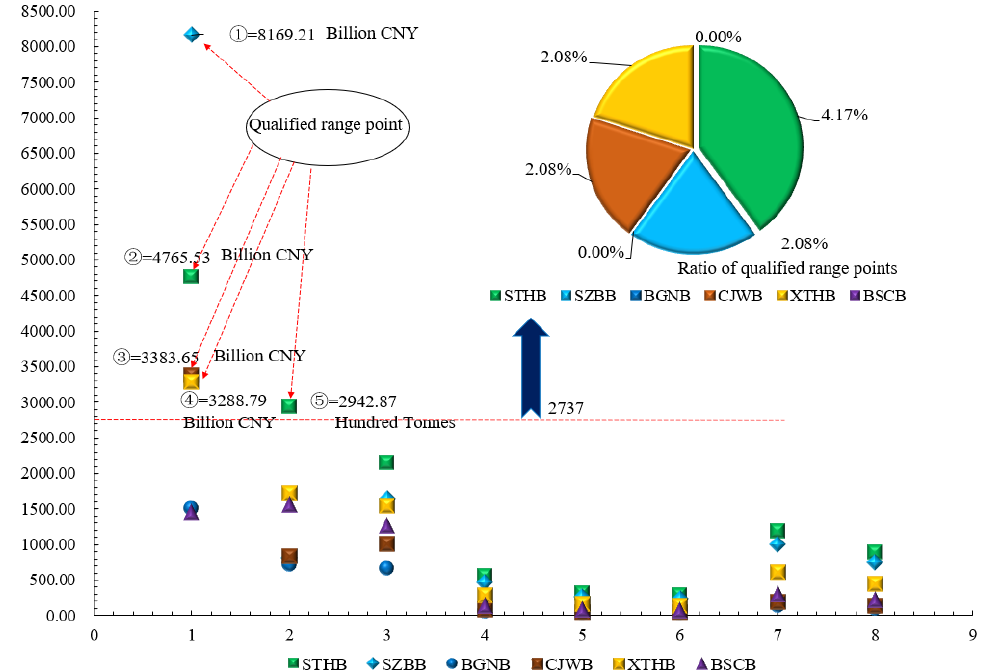
Figure 10. Schematic diagram of discrete points for comprehensive evaluation.